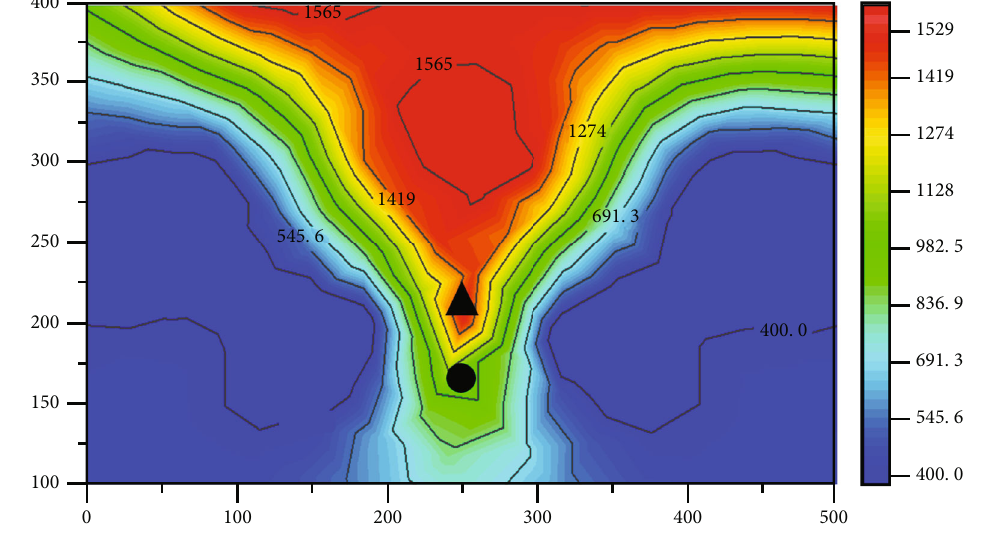
Figure 5: Pressure distribution at the end of the experiment (220 ° C, kPa).